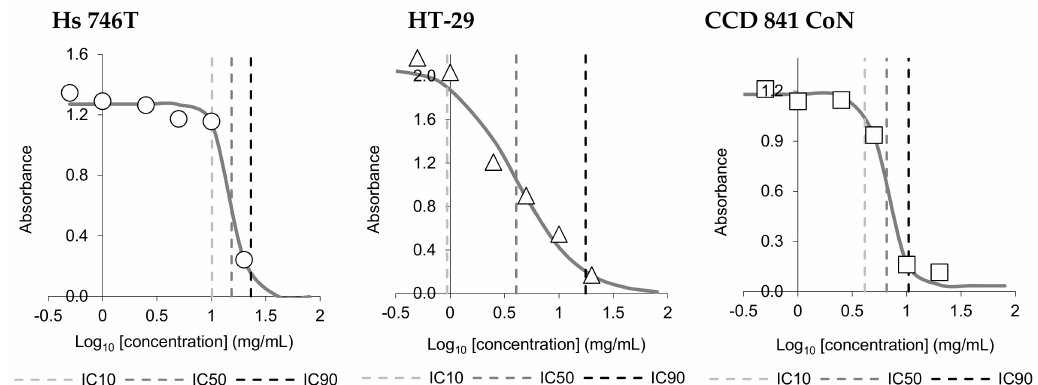
Figure 2. Changes in cell proliferation and viability upon treatment of the stomach cancer cells (Hs 746T line), colon cancer cells (HT-29 line), and colon normal cells (CCD 841 CoN line) with PJPC at concentrations ranging from 0.5 to 20 mg /